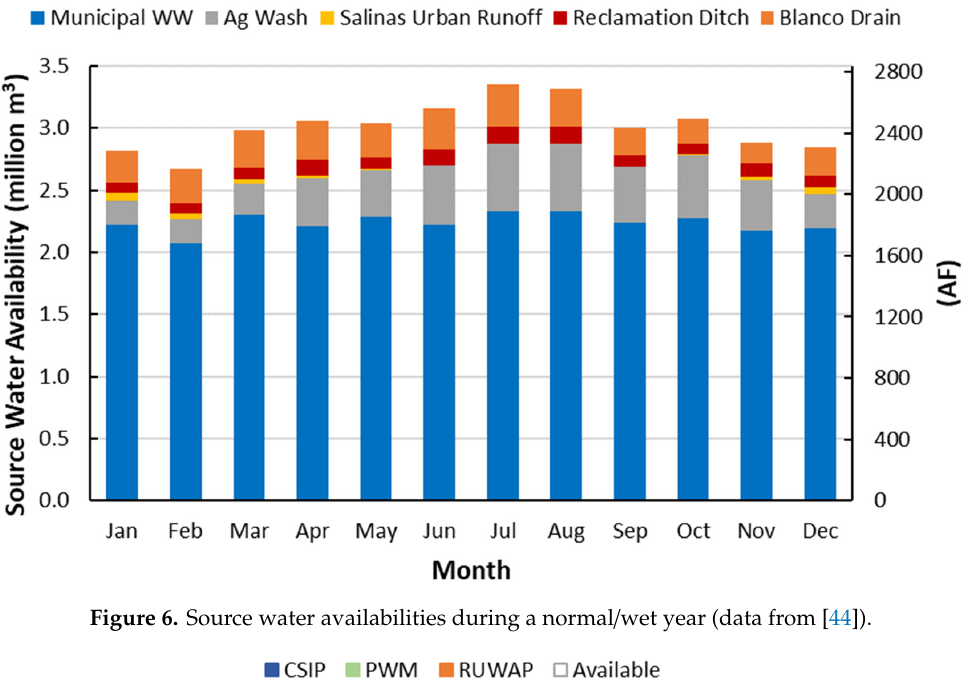
Figure 6. Source water availabilities during a normal/wet year (data from [44]).